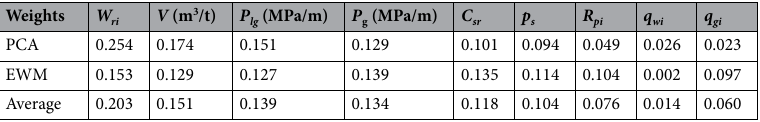
Table 2. Evaluation index weight.